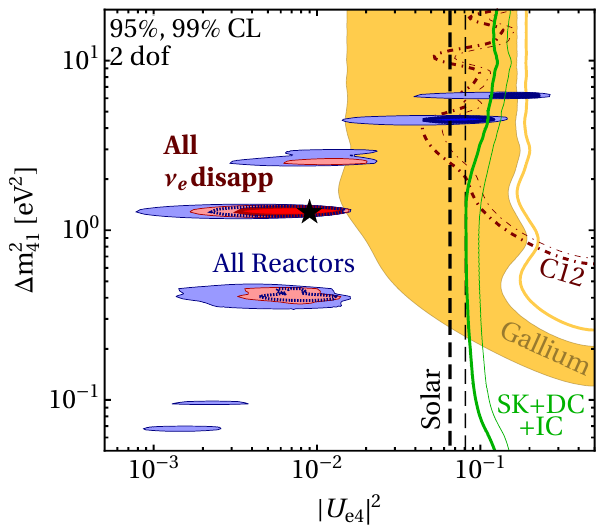
Figure 3 . Constraints on (cid:23) e /(cid:22) (cid:23) e disappearance in the 3 + 1 scenario. We show the preferred parameter regions at 95% and 99% CL, projected onto the plane spanned by the mixing matrix element j U e 4 j 2 and the mass squared di(cid:11)erence (cid:1) m 2 . The parameter space inside the shaded areas 41 and to the left of the exclusion curves is allowed. For the reactor analysis we adopt the conservative assumption of free (cid:13)ux normalizations. The red region includes all data listed in table 1. The green curves show the limit on j U e 4 j 2 obtained from atmospheric neutrino data from SuperK, IceCube and DeepCore, discussed in section